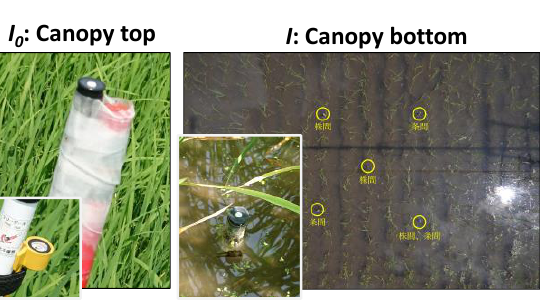
Figure 2. RGB image, color index and green leaves area Figure 3. PPFD measurement at the top and bottom of